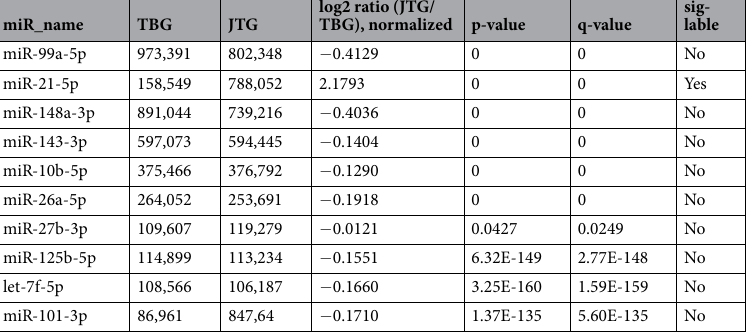
Table 3. Comparison of the 10 most abundant conserved miRNAs in the ovarian libraries of the two goat